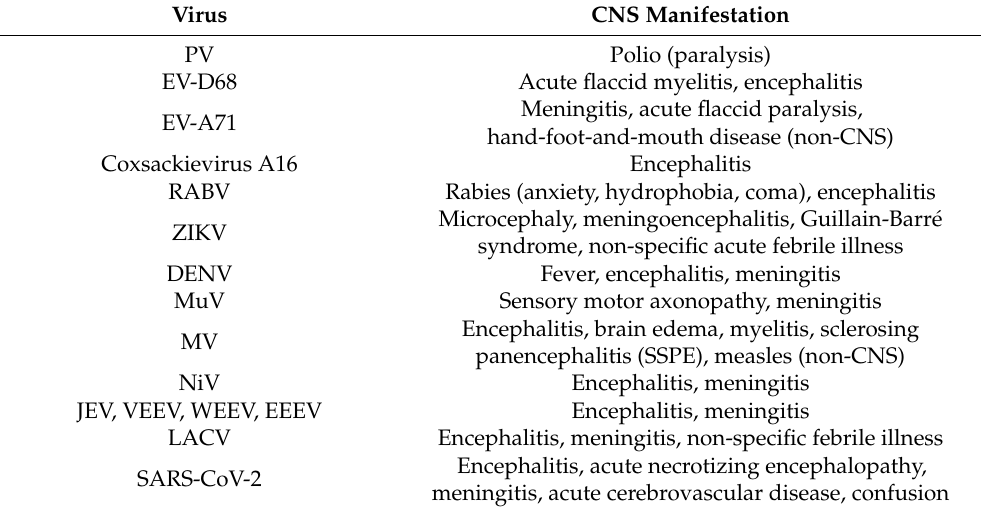
Figure 1. RNA viruses can be neurotropic. ( A ). Schematic of RNA virus entry into the central nervous system (CNS). Neurotropic viruses can infect human hosts via at least two routes of transmission: (1) respiratory droplets or (2) through the bite of an infected insect vector. Upon entry through the blood–brain barrier (BBB) and into the CNS, viruses can infect several CNS cell types, including astrocytes, microglia, and neurons. ( B ). Schematic of known immune modulation strategies enacted by viruses within the CNS. Arrows indicate activation while blunt-end arrows represent inhibition. Blue blocks indicate a strategy that can either increase or decrease interferon, while purple blocks indicate a strategy that decreases interferon. Created with BioRender.com. Table 1. Central nervous system (CNS) manifestations during neurotropic virus